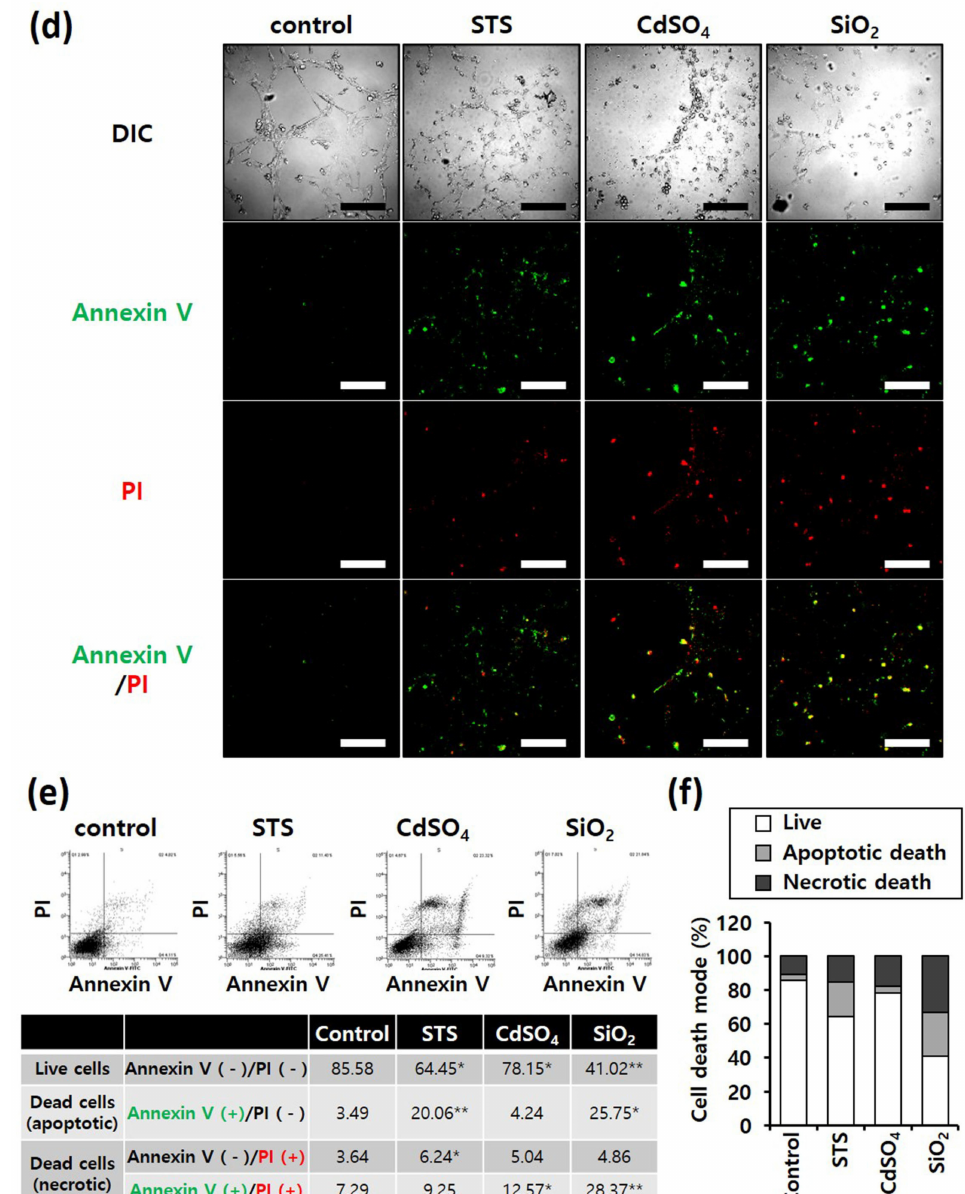
Figure 4. Annexin-V/PI double-staining assay of HepG2 and HH cells; After treating HepG2 and HH cells with SiO 2 NPs (at IC50) and two positive controls, the cells were stained with annexin V-fluorescein isothiocyanate and propidium iodide and analyzed by fluorescence microscopy and flow cytometry. CdSO 4 (1.0 mM) was used to induce necrosis, and staurosporine (STS; 1.0 µ M) was used to induce apoptosis; replicate number = 3. ( a , d ) Confocal fluorescence microscopy images; scale bars represent 200 µ m. ( b , e ) Flow cytometry analysis. * p < 0.05, compared with control; ** p <